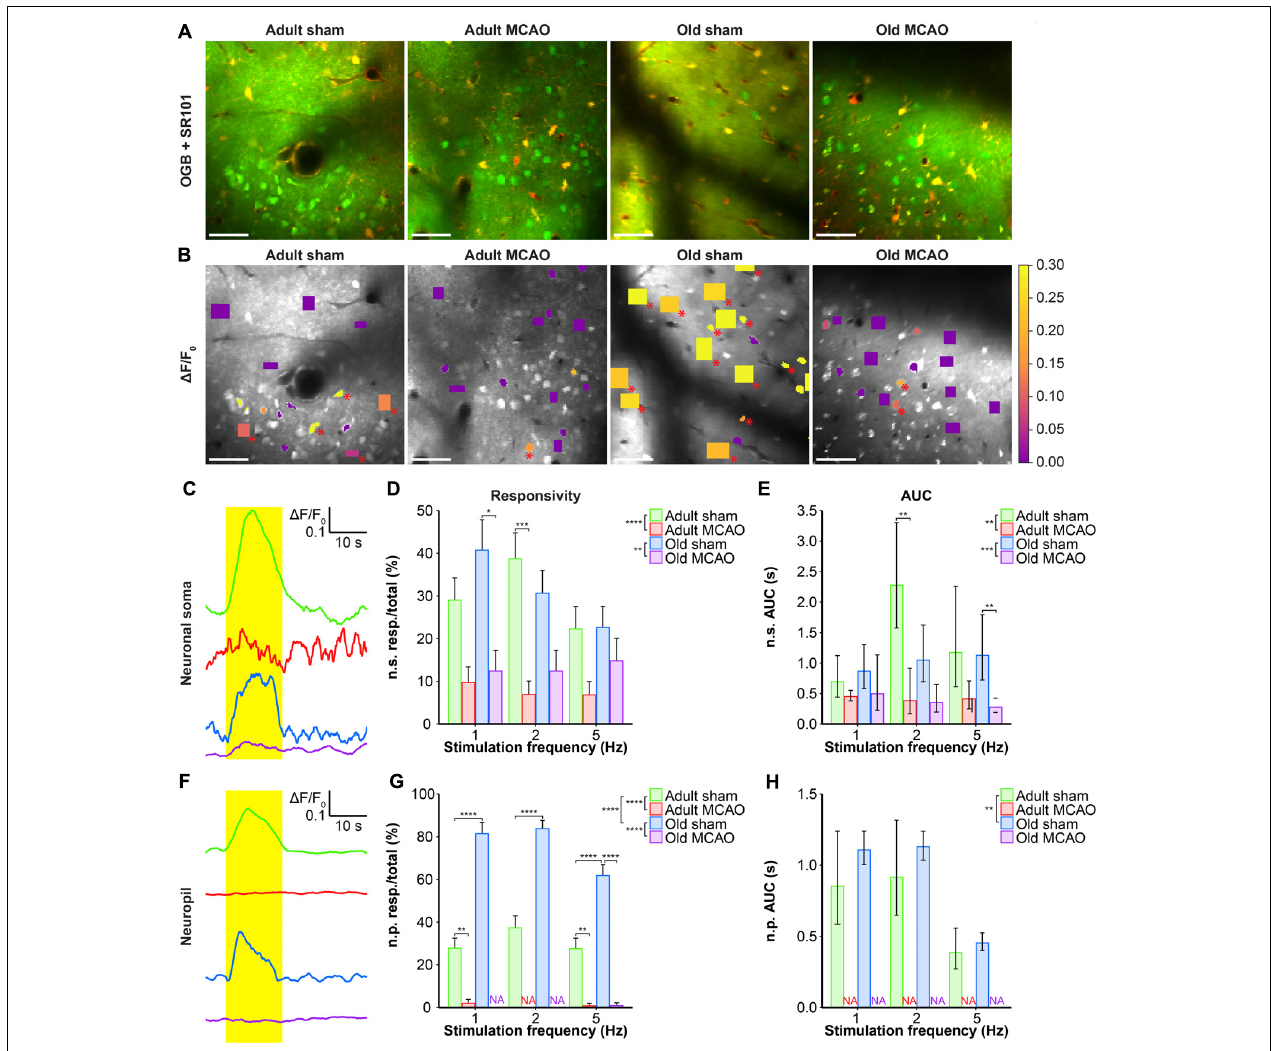
FIGURE 3 | Stroke reduced the evoked Ca 2 + signals in neuronal somas and neuropil in the penumbra. (A,B) Representative two-photon images recorded in adult and old mice after sham operation or permanent middle cerebral artery occlusion (MCAO). (A) Green indicates Oregon Green 488 BAPTA-1/AM (OGB). Red indicates sulforhodamine 101 (SR101). (B) OGB is shown in gray. Mean (cid:49) F/F 0 during 2-Hz whisker stimulation is color-coded for neuronal somas (n.s.) and neuropil (n.p.). Red asterisk ( ∗ ) indicates responsive regions of interest (ROIs). Scale bar = 50 µ m. (C,F) Representative smoothed traces of (cid:49) F/F 0 from neuronal ROIs (C) and neuropil ROIs (F) , upon stimulation at 2 Hz for 15 s, from adult sham (green), adult MCAO (red), old sham (blue), and old MCAO (purple) mice. (D) Compared to age-matched sham controls, stroke reduced the evoked neuronal soma responsivity in adult mice (2 Hz, p = 0.0006) and old mice (2 Hz, p = 0.0291). Responsivity is given as the fraction of responsive (resp.) ROIs relative to the total number of ROIs. (E) Compared to in age-matched sham controls, the evoked Ca 2 + response area under the curve (AUC; (cid:49) F/F 0 × s) was reduced by 34–83% in the neuronal somas of adult and old mice after stroke. (G) Compared to age-matched sham controls, stroke reduced neuropil responsivity in adult mice (1 Hz, p = 0.0028; 5 Hz, p = 0.0080) and old mice (5 Hz, p < 0.0001). (H) Evoked neuropil Ca 2 + response AUC ( (cid:49) F/F 0 × s) during whisker stimulation. Neuropil responsivity and AUC increased with healthy aging. Values are given as the fraction ≤ standard error of probability for responsivity, and back-transformed estimates ± 95% confidence intervals for AUC. Permanent MCAO totally abolished evoked Ca 2 + responses in neuropil; therefore, the AUC was not examined (NA). Responsivity was analyzed using multinomial logistic regression, and AUC using linear models—both with Holm-Sidak post hoc tests. ∗ Significant difference between treatments (i.e., experimental conditions). ∗ in the legend indicates overall effects, while symbols over bars indicate the group difference for an individual stimulation frequency. ∗ p ≤ 0.05, ∗∗ p ≤ 0.01, ∗∗∗ p ≤ 0.001, ∗∗∗∗ p ≤